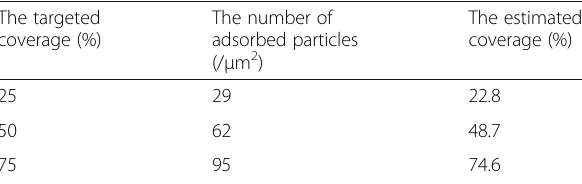
Table 1 The number of adsorbent particles and coverage estimated from SEM images The targeted coverage (%)